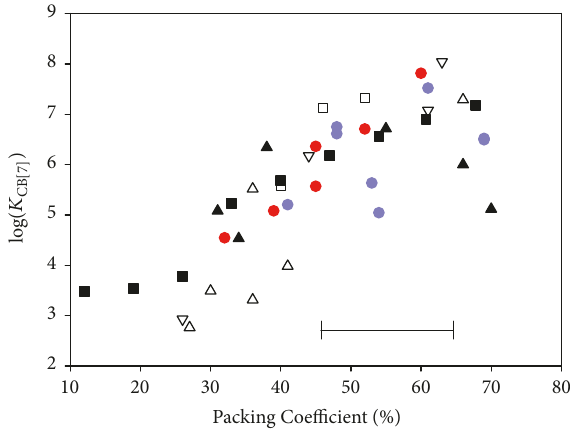
Figure 5: Plot of log( 𝐾 ) against the packing coefficient for CB [7] the CB [7] complexes of the (blue circle) amine boranes and (red circle) isostructural alkylammonium cations from this study, (black triangle) peralkylated onium cations [27, 28], (black square) n- alkanes [35], (empty triangle) ketones [34], (empty square) bicyclic azoalkanes [31], and (empty down triangle) perfluorinated alkanes and alcohols [32]. The horizontal line represents Mecozzi and Rebek’s optimal packing coefficient of 55 ± 9 % [30].